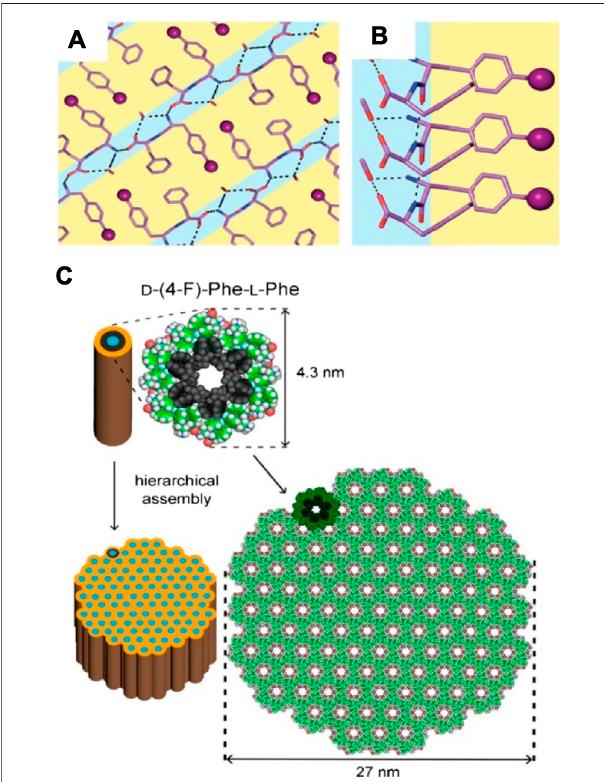
FIGURE 12 | (A) and (B) Single-crystal XRD structure of D-(4-I)-Phe-L- Phe (CCDC 016374). The light blue represents the hydrophilic layers and iodine atoms (purple sphere) allowed Phe side chains in hydrophobic layers (yellow); (C) single-crystal XRD structure (CCDC 2016373) of D-(4-F)- Phe-L-Phe, which can pack to an intermediate level of bundling to generate 27 nm wide fi brils as observed by TEM (Kralj et al., 2020).